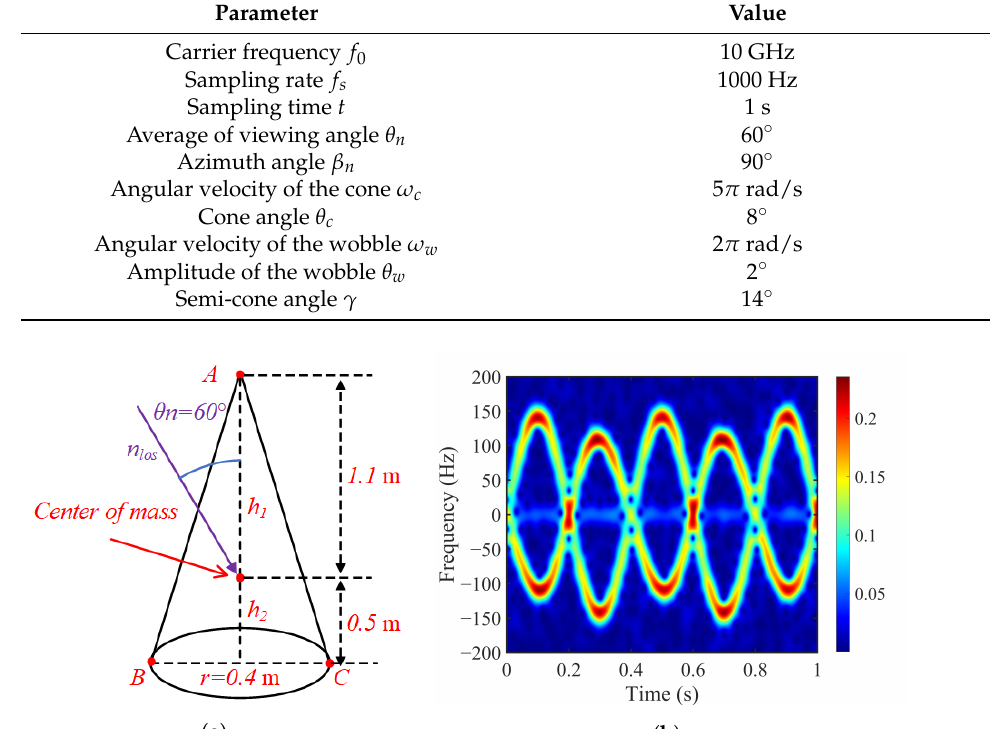
Figure 4. Target model and TFD. ( a ) A flat-bottomed cone-shaped target with a rotationally symmetric structure. A,B and C are the three scattering centers of the cone-shaped target. ( b ) STFT